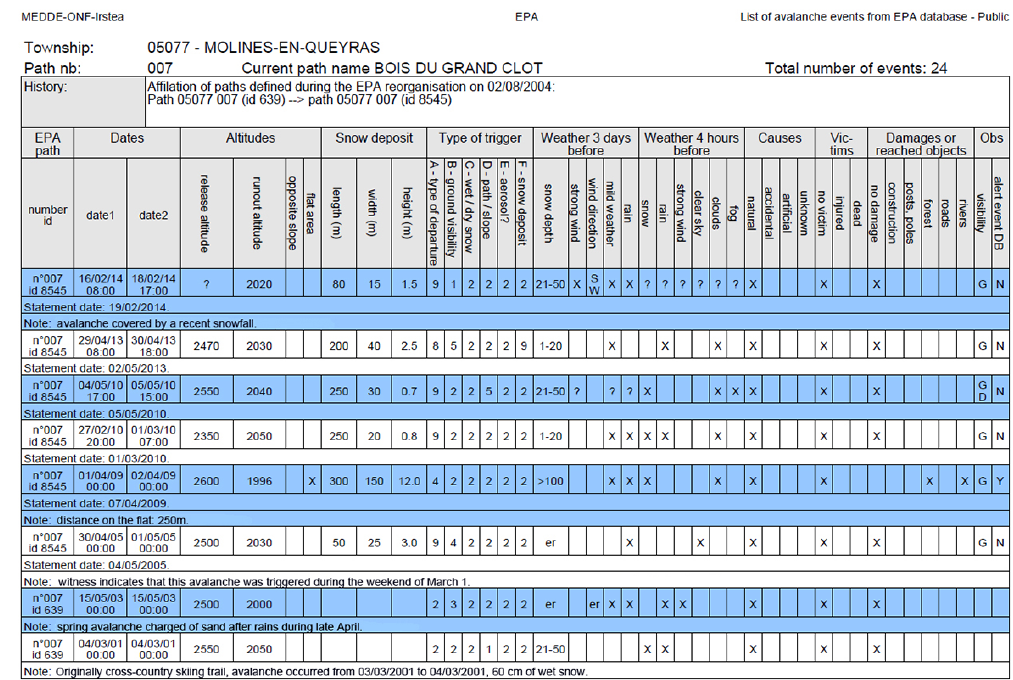
Figure 2. The first page of a PDF document listing recent avalanche events observed on EPA path number 7 from Molines-en-Queyras township shown in Fig. 1. In total, 24 events have been observed on this path since